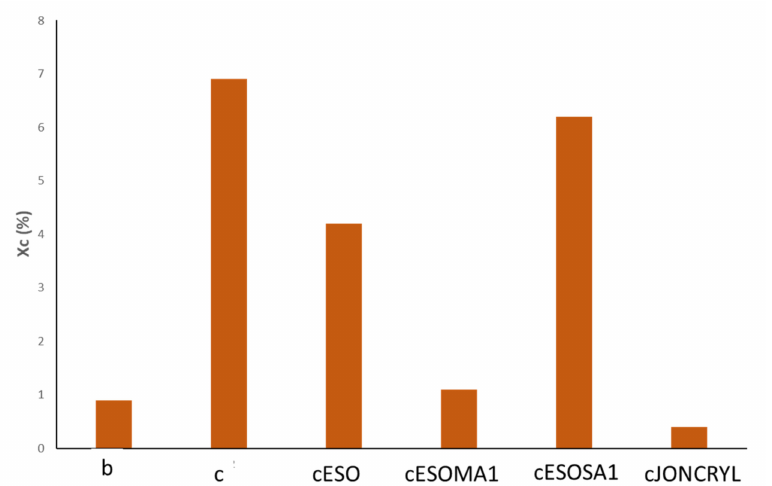
Figure 10. Crystallinity of the selected formulation (second heating scan). b is the PLA/PBSA 60/40 blend; c is the composite with 20% bran; cESO is the composite plasticized with ESO; cESOMA1 is the composite with ESO + MA; cESOSA1 is the composite with ESO + SA; cJONCRYL is the composite with